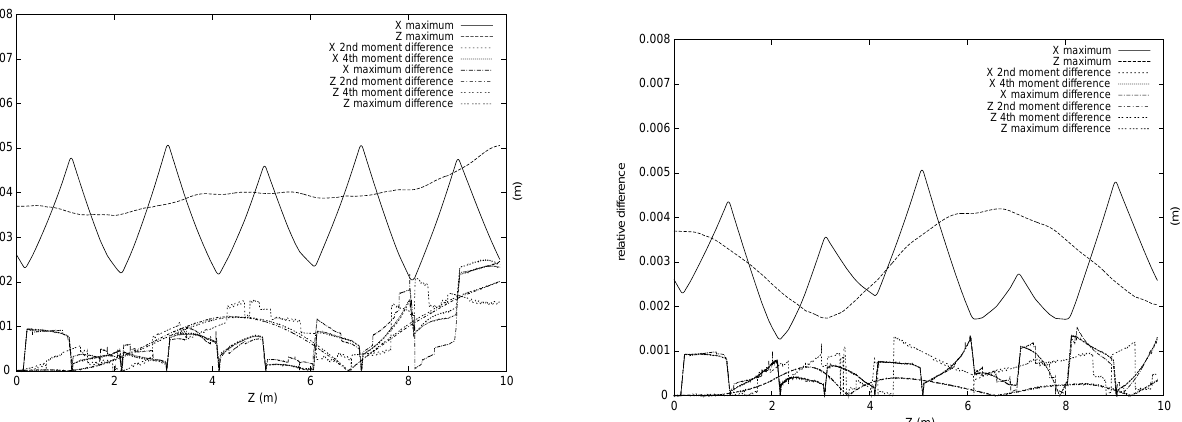
FIG. 3. The relative difference between the z -dependent macroparticle simulation and the t -dependent simulation, and the maximum particle amplitude as a function of position in the reference case.